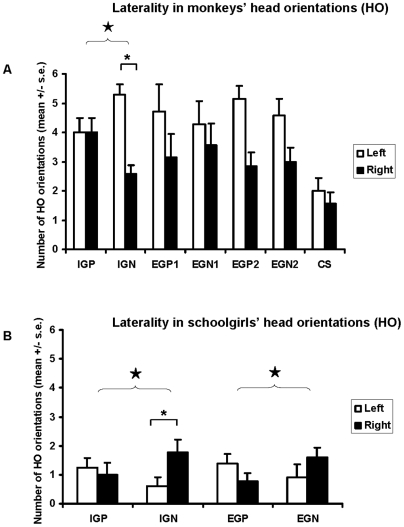
Laterality of head orientations in relation to sound categories for monkeys and girls.Values shown are the means±s.e. Stimuli – IG: intra-group, EG: extra-group, P: positive, N: negative, 1: De Brazza monkeys, 2: red-capped mangabeys, CS: control sound. Asterisk: Result of Wilcoxon test: p<0.05 Open star: Result of Fisher test: p<0.05.